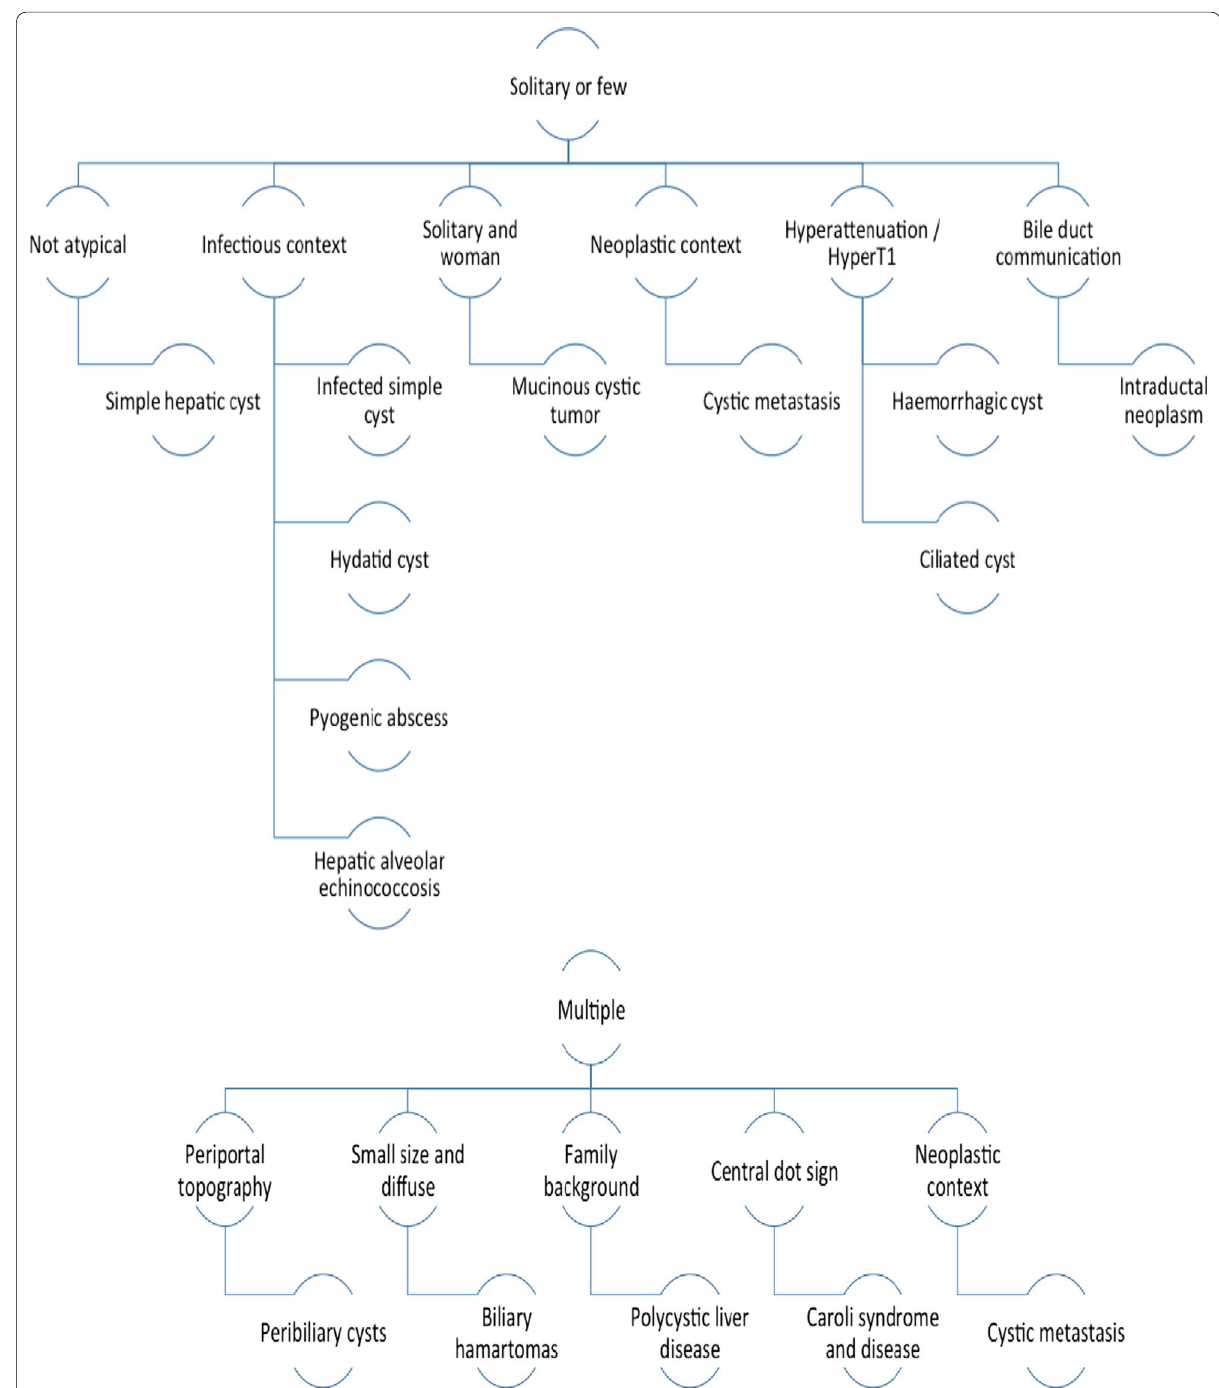
Fig. 1 Simple algorithms helping to delineate diagnosis according to the number of